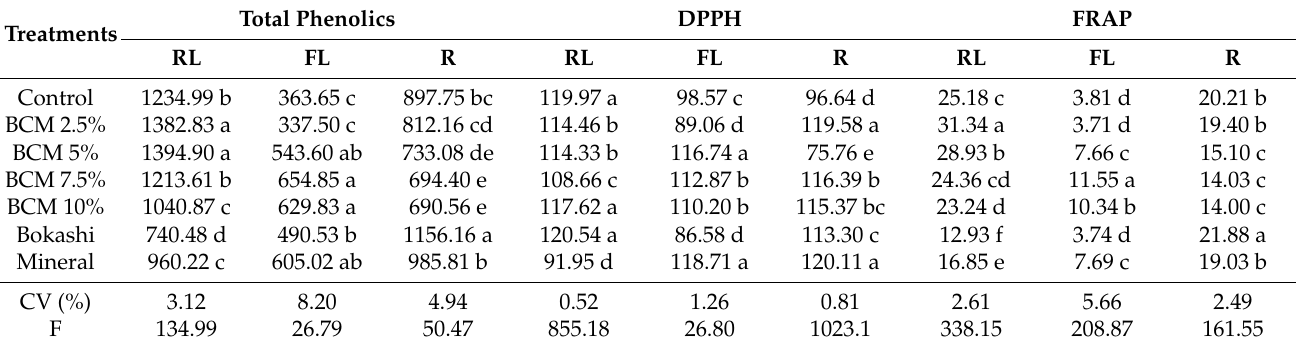
Table 4. Means of total phenolics and antioxidant activity evaluated using DPPH and FRAP methods of romaine (RL) and fris é e (FL) lettuce cultivars, and radicchio (R) chicory submitted to different concentrations of boiled chicken manure (BCM), bokashi, and mineral fertilization in a greenhouse. Londrina, Paran á State, Brazil, 2020.